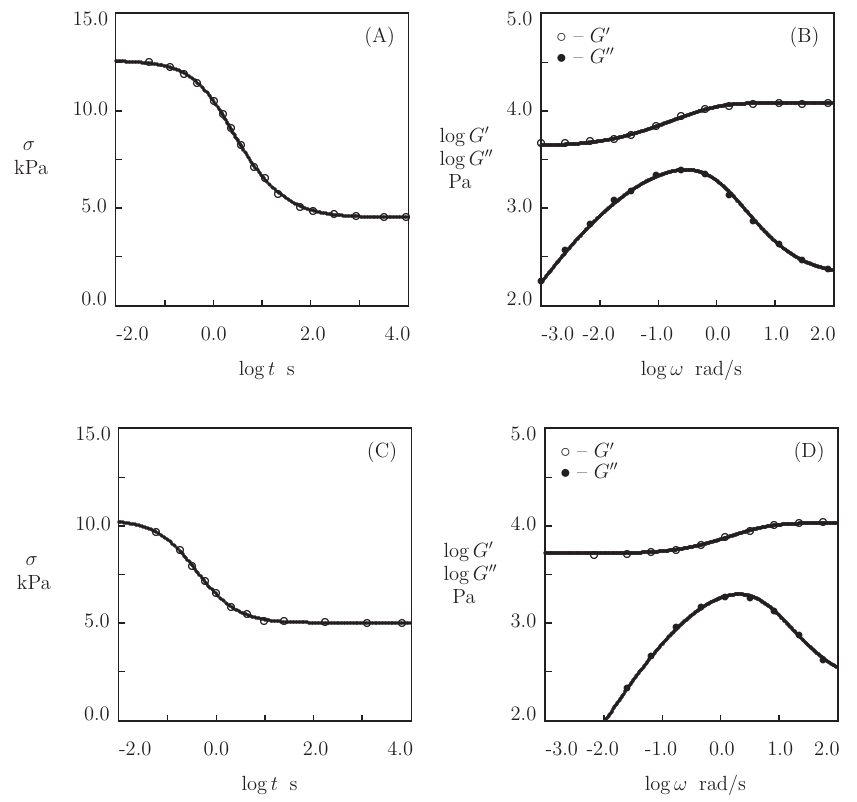
Figure 9. ( A , C )–Shear stress σ versus relaxation time t . ( B , D )–Storage modulus G (cid:48) and loss modulus G (cid:48)(cid:48) versus frequency ω . Symbols: experimental data [47] on PEG-L37I ( A , B ) and PEG-L37V ( C , D ) gels. Solid lines: the results of